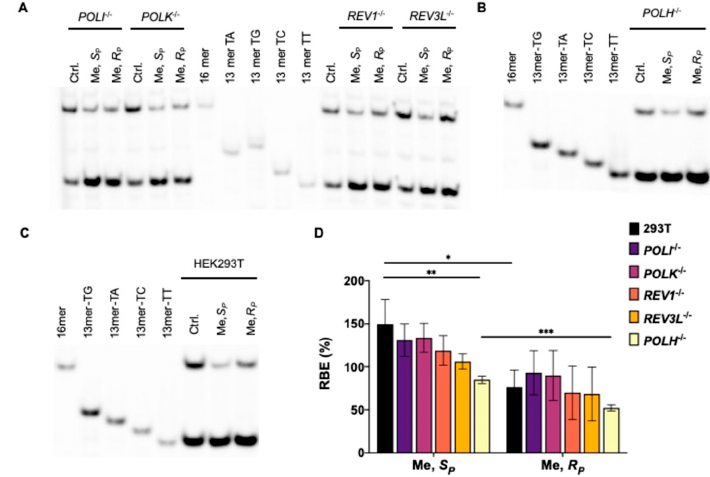
Figure 2. Transcriptional bypass of Me-PTE in HEK293T cells and isogenic cells depleted of TLS polymerases. ( A – C ) Gel image showing the 16 mer (from the competitor genome) and 13 mer (from the control or lesion-containing genome) digestion products formed from the original template strand, where 13 mer TG/TA/TC/TT designate [5 ′ - 32 P]-labeled stand- ard ODNs 5 ′ -CATGGCMNGCTAT-3 ′ , with ‘MN’ being TT, TG, TC and TA, respectively. ( D ) The relative bypass efficien- cies (RBE) of the two diastereomers of Me-PTE lesions in HEK293T cells and the isogenic cells depleted of TLS polymer- ases. The data represent mean ± S.D. (n = 3). *, 0.01 < p < 0.05; **, 0.01 < p < 0.001; ***, 0.0001< p < 0.001. The p values were calculated by using Sidek’s multiple comparisons test.